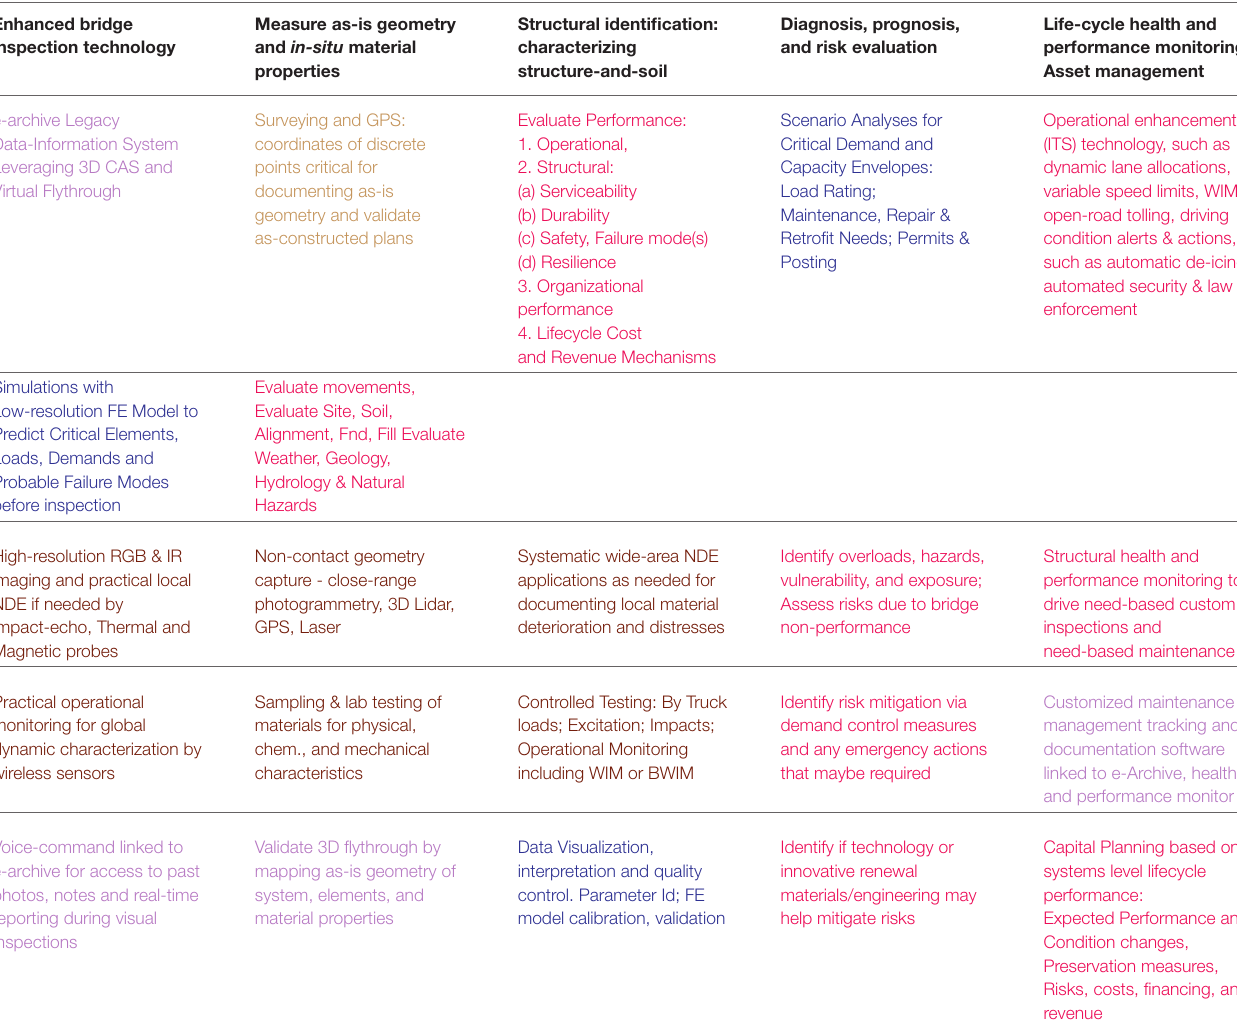
TABLE 4 | Integration of technology tools for bridge asset management: risk based decision making, info-technology, modeling/simulation, and experimental